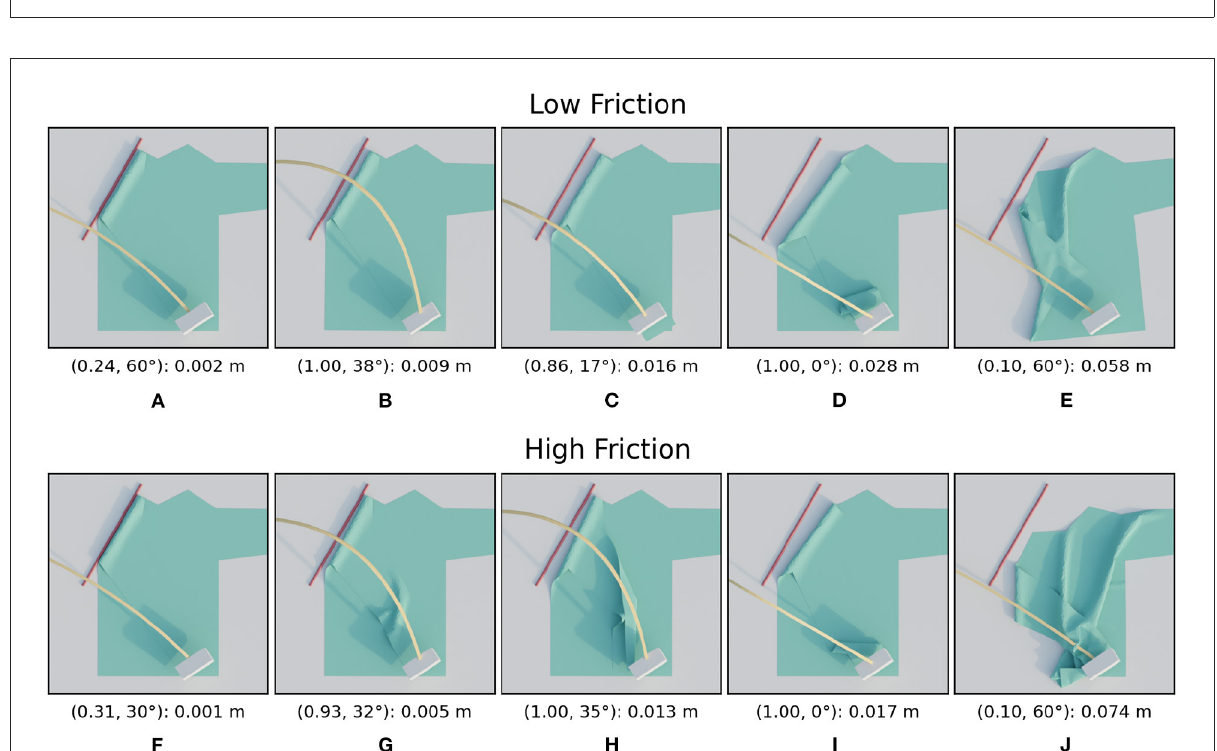
FIGURE12 Images of simulated results for the friction variations. For each row, the images are ordered from best (left) to worst (right) result. The annotation below each image is in the following format: (height ratio, tilt angle): mean distance. The first row (A–E) shows the images for the low friction scenario and the second row (F–J) for the high friction